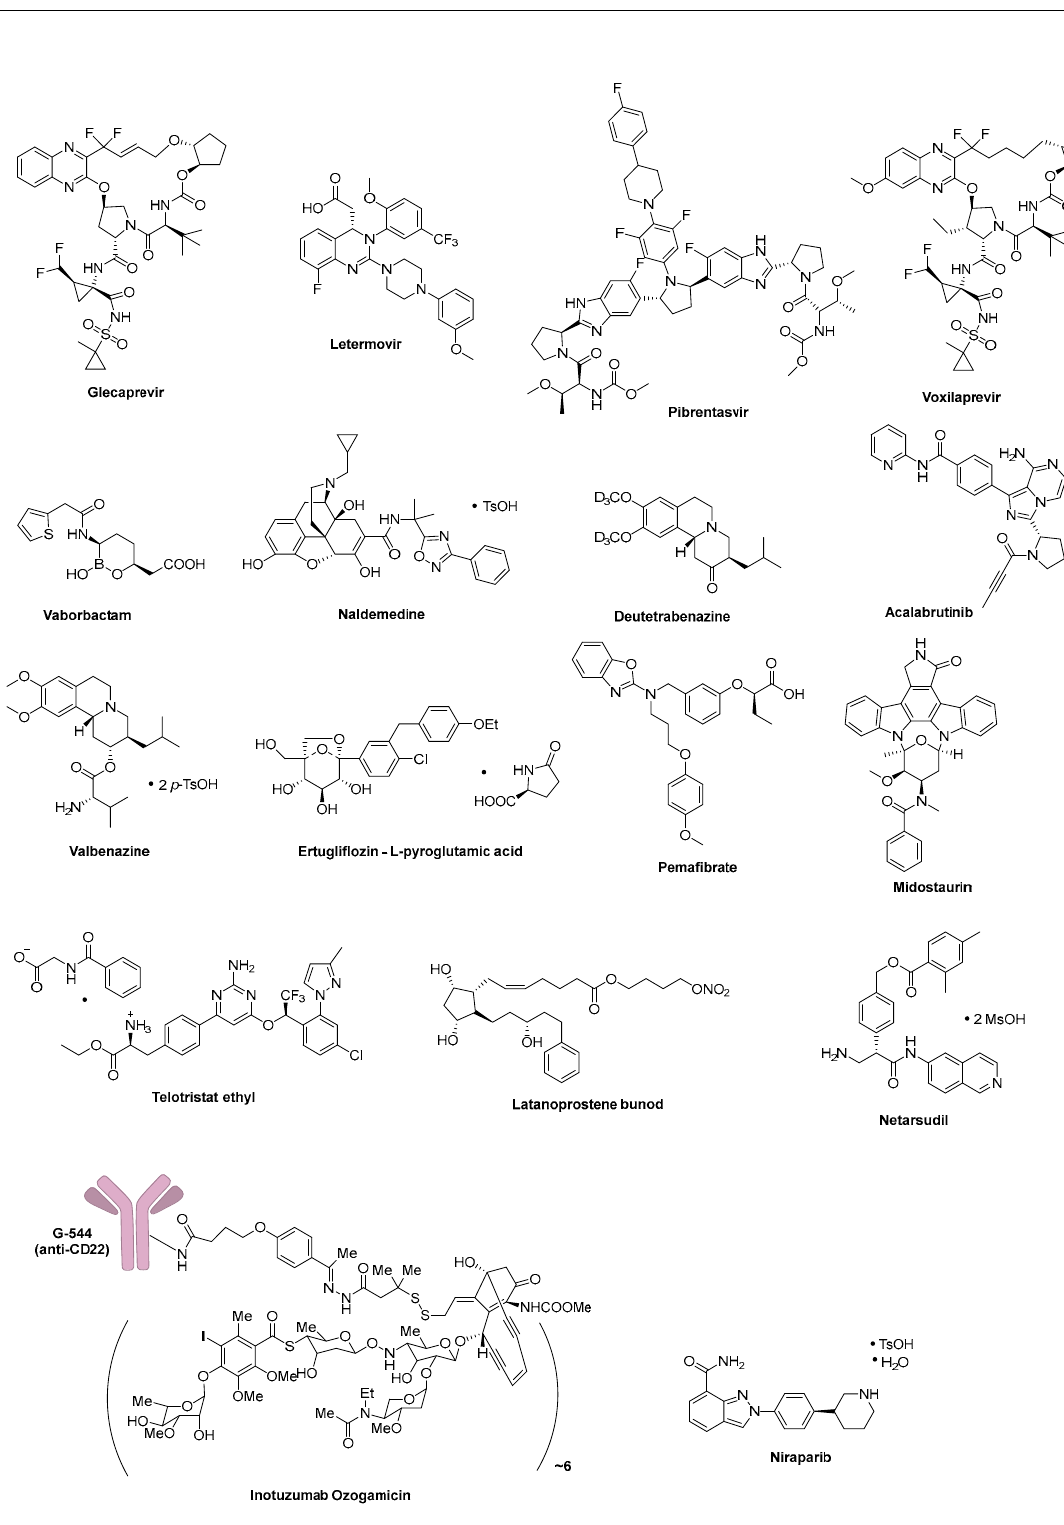
Figure 3. Structure of chiral drugs approved in 2017.